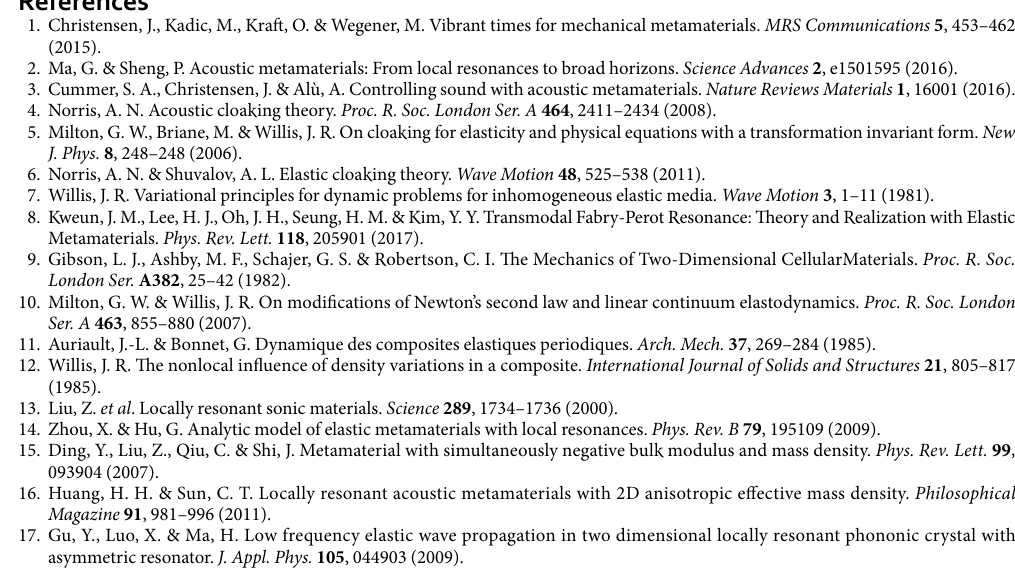
inclusion material is very soft. The sharpened bar inclusion is designed by mimicking the sliding-boundary effect in fluid-solid composites in order to pursue the broadband anisotropic density. Effective medium methods of metamaterials have been developed, making the micro-macroscopic relationships clearly identified. Note that the proposed solid metamaterials with dual anisotropy, if the Willis couplings are further incorporated, would fulfill the requirement of transformation elastic theory 5,6 . However, under some special forms of coordinate transfor- mations, for example in the case of linear transformation, the Navier elastodynamic equation retains its original form. It is the case where elastic wave controlling can be made possible by using our dual-anisotropic materials without requesting Willis coupling effect. In our model, the dynamic coupling between the host and soft inclusion is very weak, allowing us to modu- late the overall stiffness without influencing anisotropic densities. We have then proposed a significant reduced model by diminishing the shear stiffness of the metasolid, which is the so-called pentamode material with aniso- tropic inertial. Pure pentamode materials 39–42 with the anisotropic stiffness only, suggested firstly by Milton and Cherkaev 37 , have only one non-zero elastic eigenvalue that is of the hydrostatic stress state, exhibiting therefore the fluid-like elasticity. They belong to a special scenario of transformed acoustic equations 43,44 . The most general material form enabled by transformation acoustics under an arbitrary coordinate transformation refers to the PI material as realized here. All of our model studies have been validated through band-structure, effective-medium, and modal-field analyses. Results are expected to make an important step toward acoustic and elastic wave con- trolling with important applications to cloaking, seismic protection, and shock mitigation. Data Availability. The datasets generated during and/or analysed during the current study are available from the corresponding author on reasonable request.